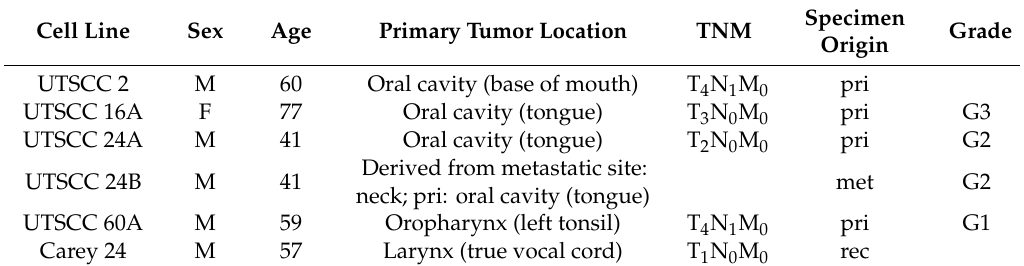
Table 1. HNSCC cell lines used for in vitro and xenograft